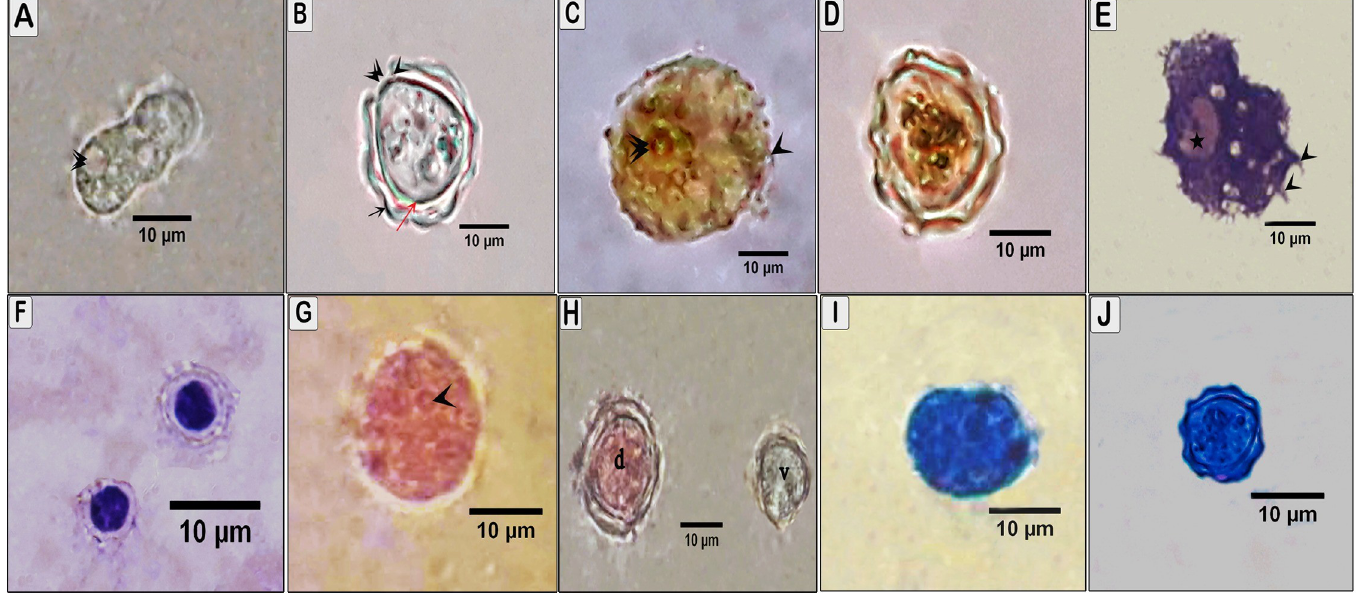
Fig 1. Light micrographs of Acanthamoeba castellanii , trophozoite and cyst staining with different stains (X1000). (A) A . castellanii trophozoite in wet mount showing vacuoles (arrowhead). (B) Unstained Acanthamoeba cysts showing wrinkled ectocyst (black arrow), smooth endocyst (red arrow) and nucleus and ostiole (arrowhead). (C) A . castellanii trophozoite stained with iodine wet mount stain trophozoite appears yellowish–brown with prominent nucleus (arrowhead). (D) A . castellanii cyst appears yellowish–brown with well-defined ectocyst and endocyst. (E) A . castellanii trophozoite stained with Giemsa stain showing prominent nucleus (star) contractile vacuole and acanthopodia (arrowhead). (F) The nucleus of cyst stained blue with Giemsa stain. (G) A . castellanii stained with eosin showing dead trophozoite appears pink color with prominent nucleus (arrowhead). (H) A . castellanii cyst showing dead cyst appears pink (d) and viable cyst unstained (v). (I) Acanthamoeba trophozoite and (J) cyst stained with methylene